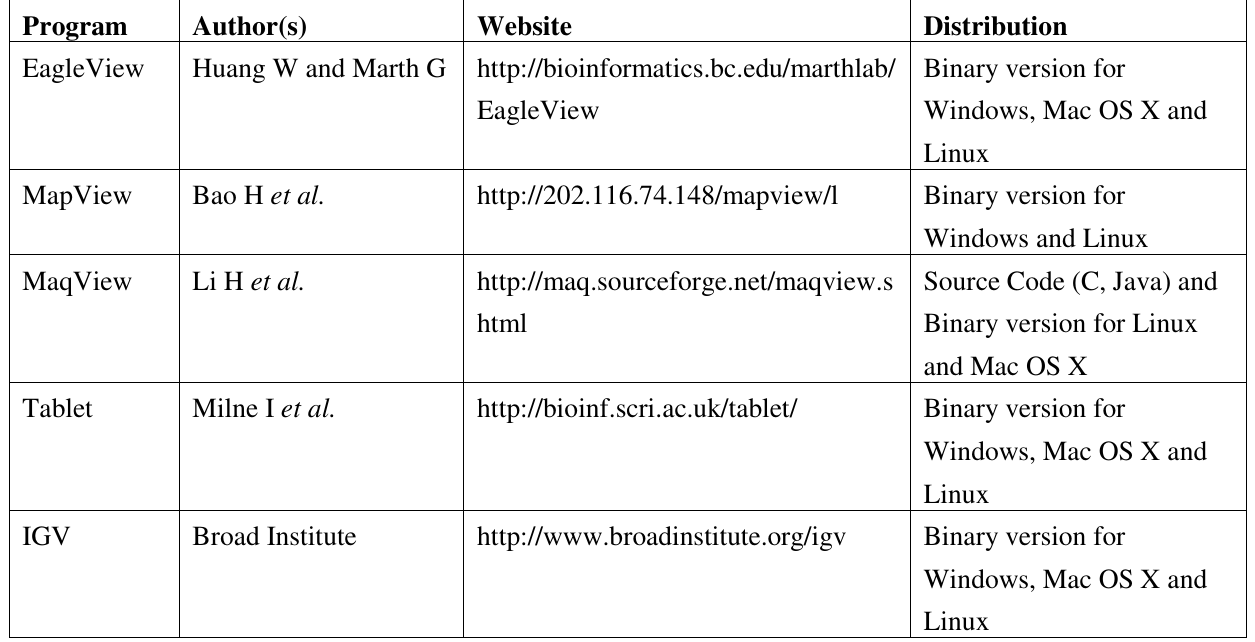
Table 3. A list of tools for the visualization of alignments or assemblies of short read